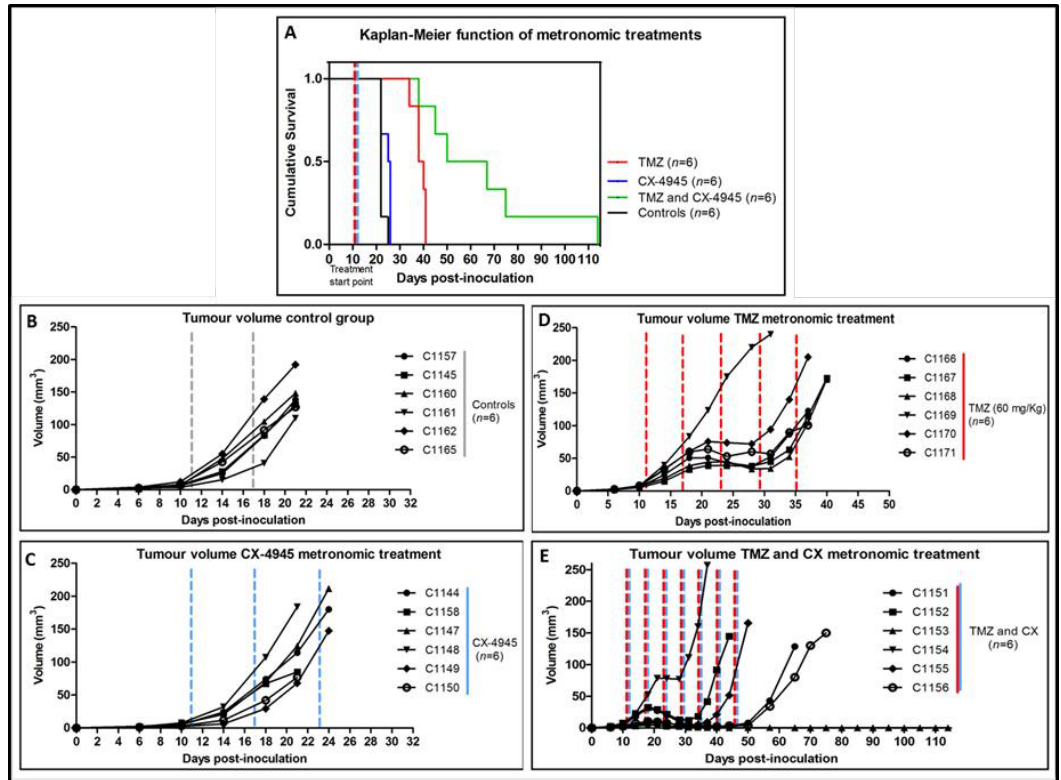
Figure 3. Tumour volumes and survival rates for 6-day metronomic treatment. ( A ) Survival Kaplan-Meier curve for metronomic CX-4945 treated mice ( n = 6), blue line, metronomic TMZ treated mice ( n = 6), red line, CX-4945 and TMZ metronomic treated mice ( n = 6), green line, and control mice ( n = 6), black line. Significant differences ( p < 0.05) were observed between all treatment groups analysed in comparison with control mice; ( B ) Tumour volumes of control mice ( n = 6); ( C ) Tumour volumes of metronomic CX-treated mice ( n = 6); ( D ) Tumour volumes of metronomic TMZ-treated mice ( n = 6); ( E ) Tumour volumes of metronomic CX and TMZ- treated mice ( n = 6). Significant differences were found between groups ( p < 0.05) when comparing control mice with treated mice, and when comparing different treatments between them (TMZ, CX-4945 and combined TMZ and CX-4945). The dashed lines indicate therapy administration points. Cxxxx corresponds to a unique alpha-numeric animal identifier code in the GABRMN